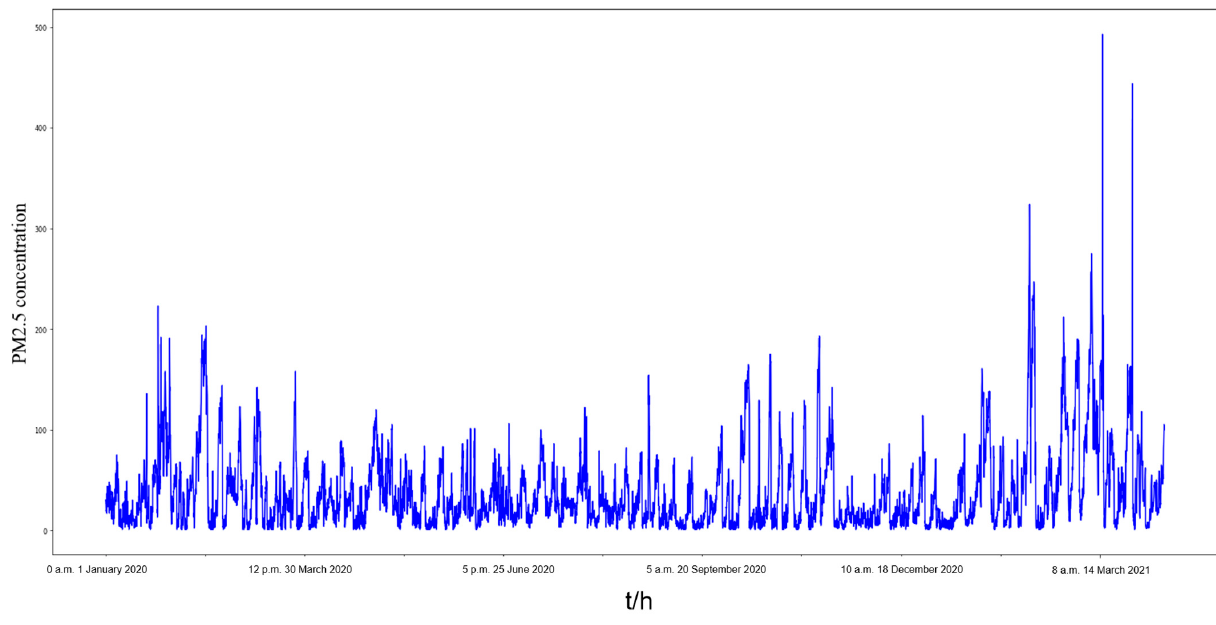
11 of 19 Figure 3. Convergence curve of algorithms on unimodal functions and multimodal functions. Subgraphs ( A – F ) represent the convergence curve of benchmark function 𝑓 (cid:2869) – 𝑓 (cid:2874) . The quality of the initial population generated by the FOSSA algo- rithm is significantly higher than other algorithms. In addition, the convergence speed and search abilities of FOSSA is better than other algorithms. 3. Empirical Results and Analysis In this section, we will use FOSSA–DeepAR model to make point prediction and in- terval prediction for PM2.5. Hourly PM2.5 concentration data observed at the Huairou